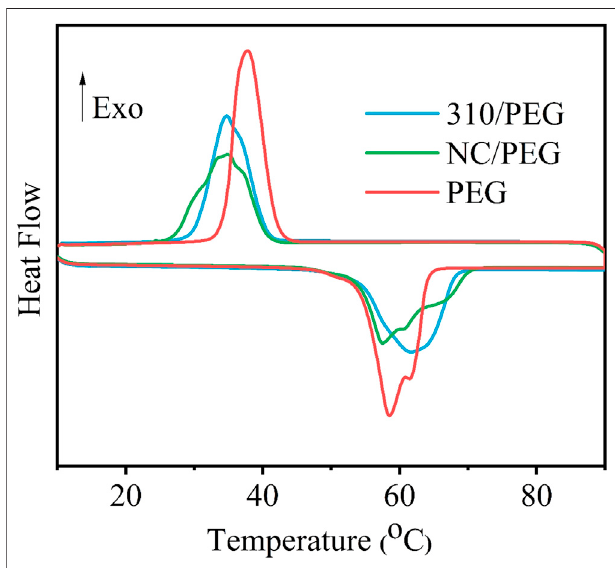
FIGURE 5 | DSC curves of the pristine PEG, the NC/PEG, and the 310/PEG.